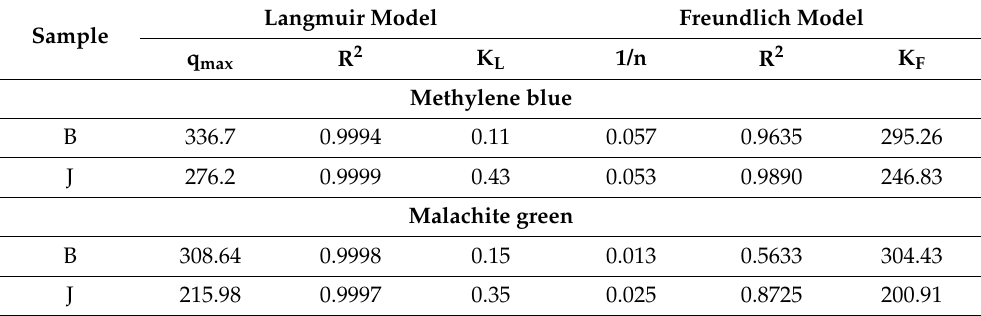
Table 3. Langmuir and Freundlich parameters of the isotherms of methylene blue and malachite green adsorption on the carbonaceous materials derived from the used carbon filters.